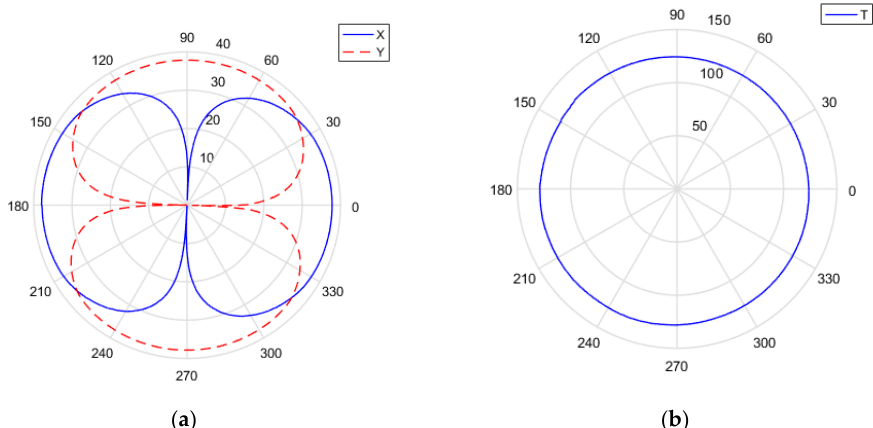
Figure 7. Directivity diagrams of sensor. ( a ) Vector channel; ( b ) scalar channel.